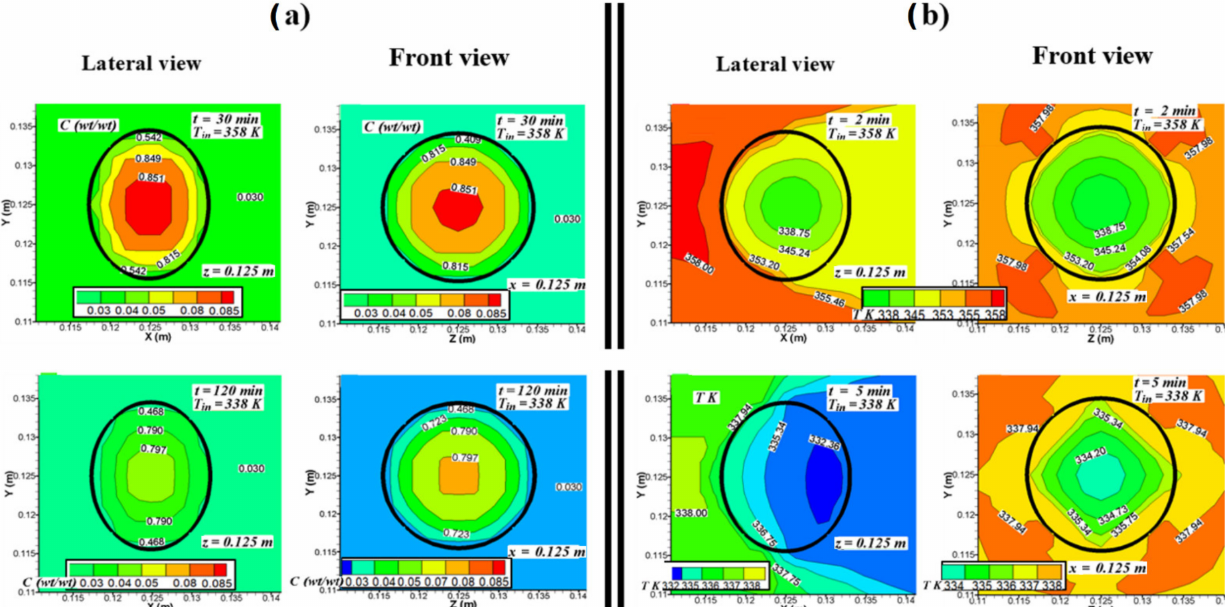
Figure 6. Moisture concentration and temperature distribution inside and around the P. peruviana fruit for lateral ( x - y plane at z = 0.125 m) and frontal ( y - z plane at x = 0.125 m) views at different time intervals. ( a ) Moisture after 30 min for T in = 358 K (85 ◦ C), and after 120 min for air inlet temperature T in = 338 K (65 ◦ C). ( b ) Temperature distribution after 2 min for T in = 358 K, and after 5 min for T in = 338